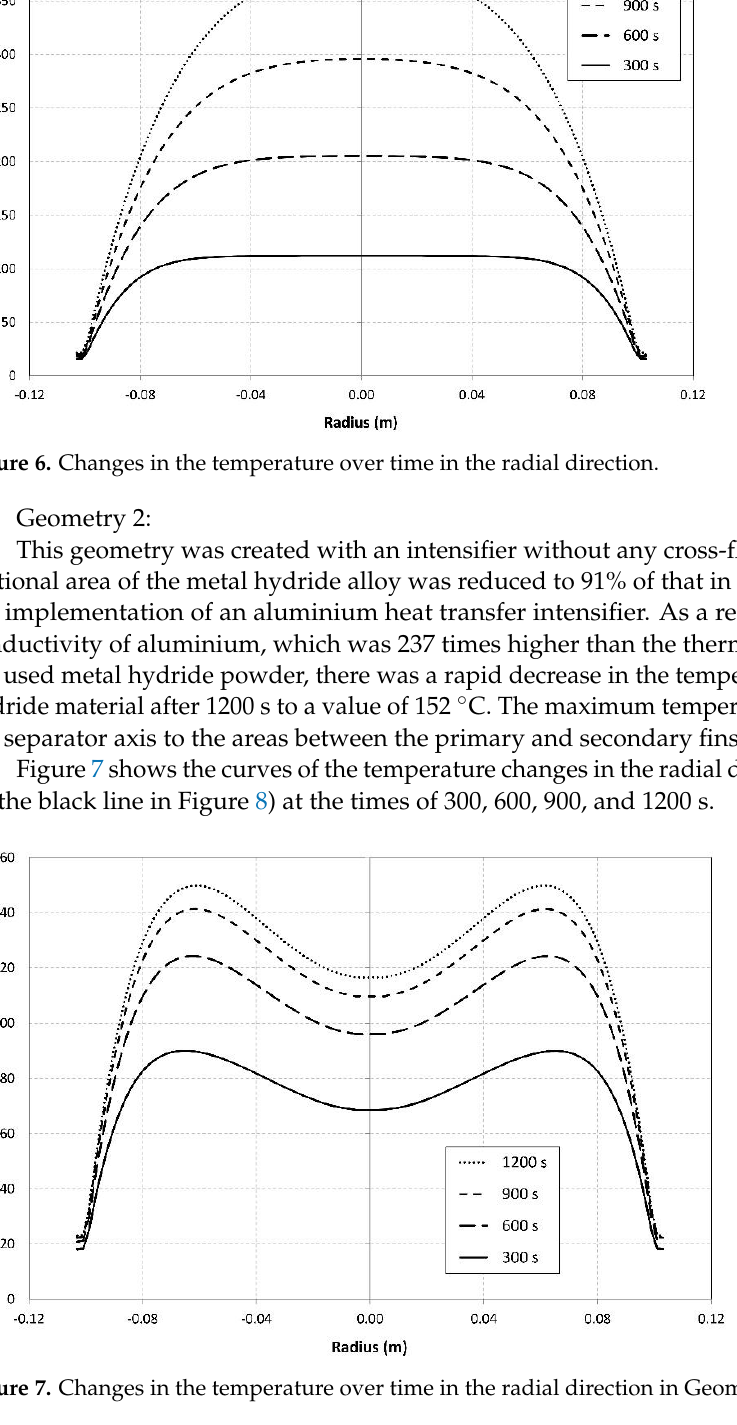
Figure 6. Changes in the temperature over time in the radial direction.